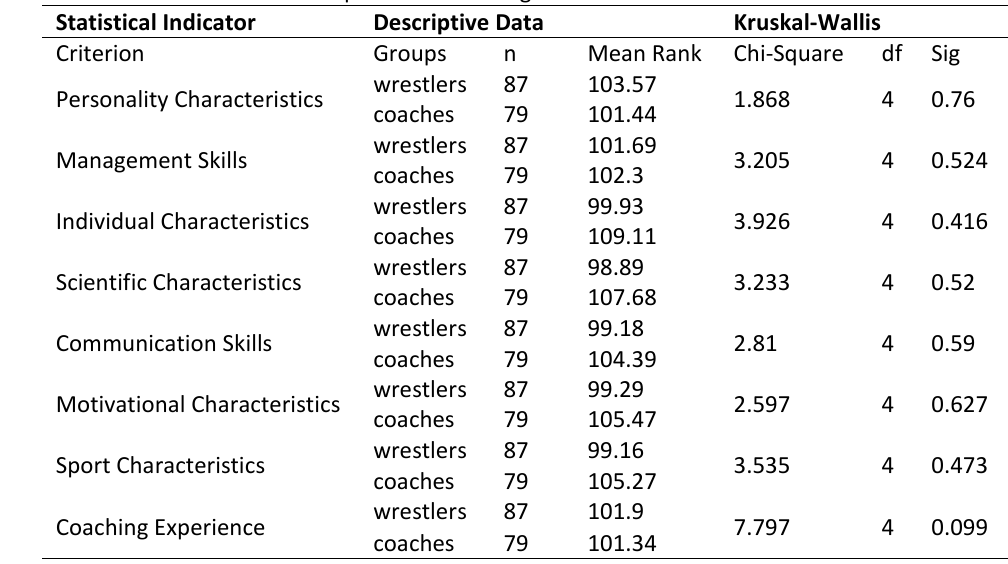
Table 3 . Results from statistical tests to prioritize coaching selection criteria Statistical